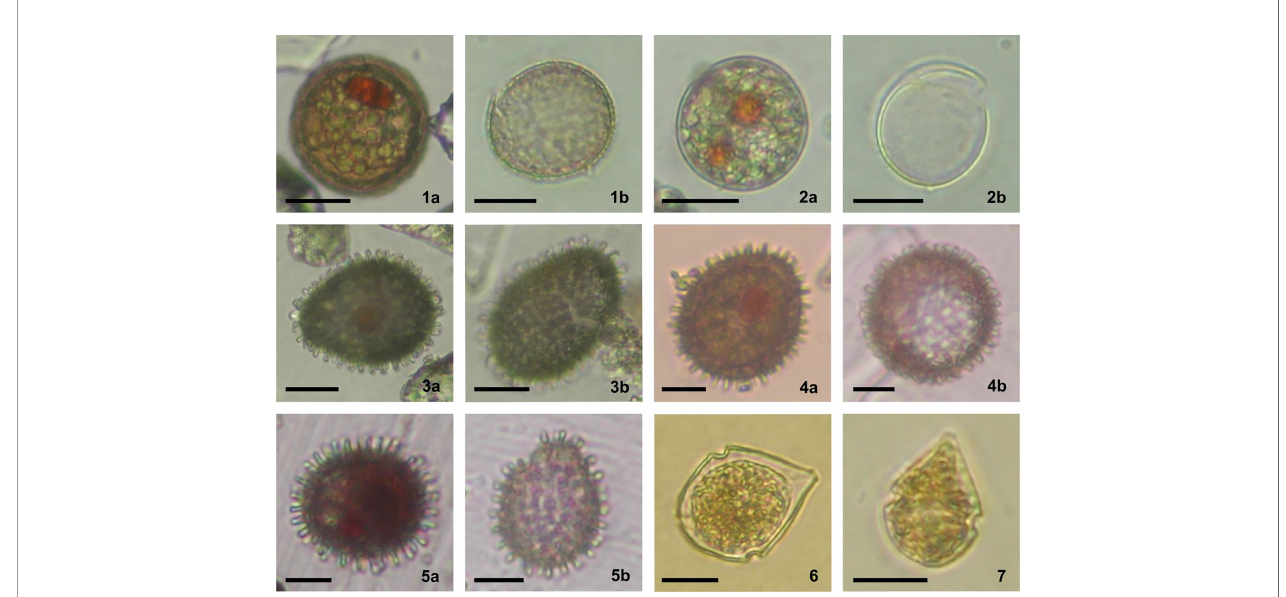
FIGURE 3 | Different cyst morphotypes produced by Scrippsiella acuminata complex, identi fi ed in the surface sediments of the Black Sea ; a and b refer to viable and germinated cysts respectively; scale bars = 20 µm, except 4a, b and 5a, b scale bars = 10 µm. 1. SaR (1a, b) – S. acuminata rough type; 2. SaU (2a, b) – S. acuminata uncalci fi ed type; 3. SaL (3a, b) – S. acuminata large type; 4. SaM (4a, b) S. acuminata medium type; 5. SaS (5a, b) – S. acuminata small type; 6. Vegetative stage produced by germination of SaR; 7. Vegetative stage produced by germination of